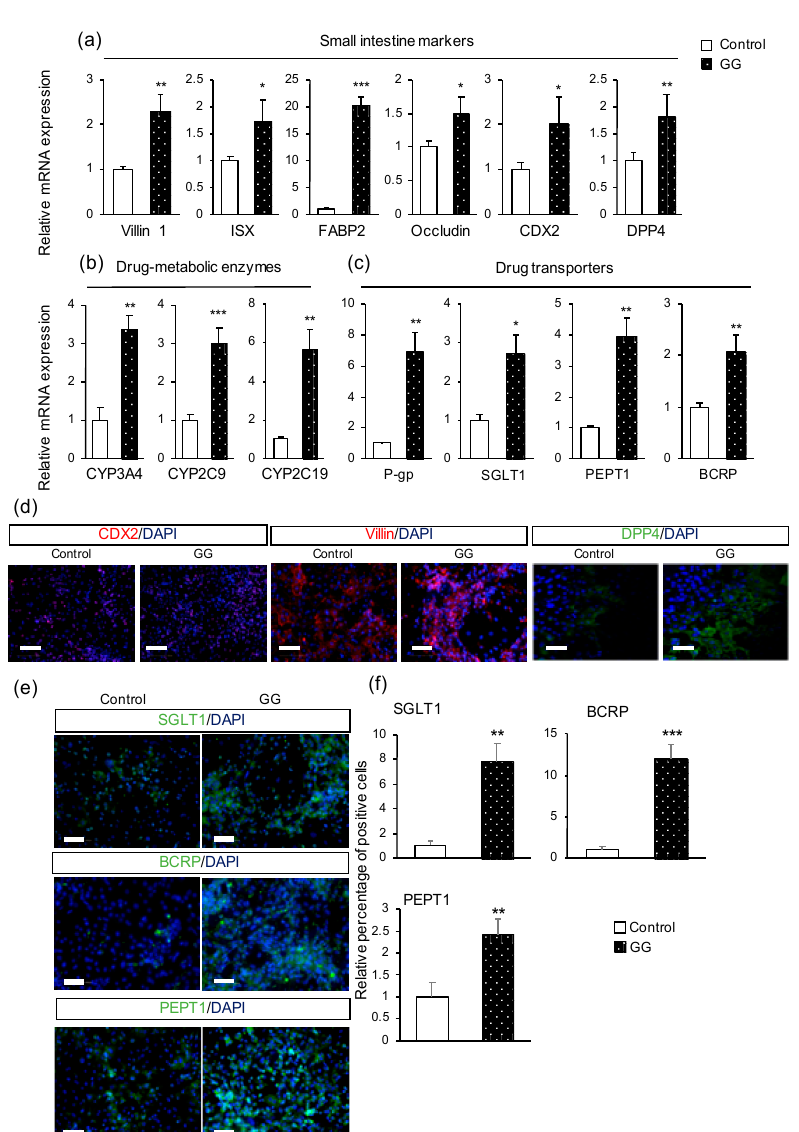
ff ect of GG on the di ff erentiation of human iPS cells into enterocytes. ( a – c ) Relative Figure 2 Figure 2. The e gene expression levels of small intestinal markers, drug-metabolizing enzymes, and drug transporter markers. ( d ) Immunofluorescence images of the small intestinal marker caudal-type homeobox 2 (CDX2) and enterocyte markers villin and dipeptidyl peptidase-4 (DPP4). ( e ) Immunofluorescence images of the drug transporter markers sodium-glucose co-transporter 1 (SGLT1), breast cancer resistant protein (BCRP), and peptide transporter 1 (PEPT1). ( f ) Relative percentage of positive cells of drug transporters. Scale bars = 100 µ m. All data are presented as mean ± S.D. ( n = 3). Control = 1. Levels of statistical significance: * p < 0.05, ** p < 0.01, *** p <